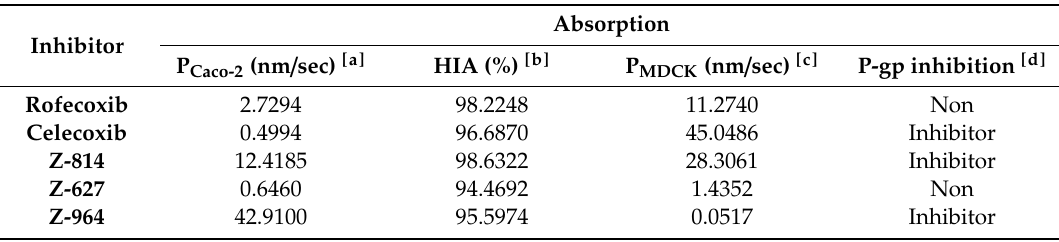
Table 9. Absorption data for selected